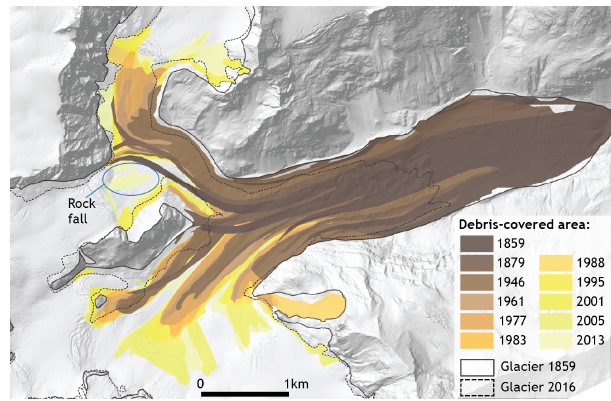
Figure 4. Cumulative length change of Zmuttgletscher with data points (vertical red lines) from this study, and several other Swiss glaciers (GLAMOS, 2018). For a list of total length and area changes see Fig. S1.